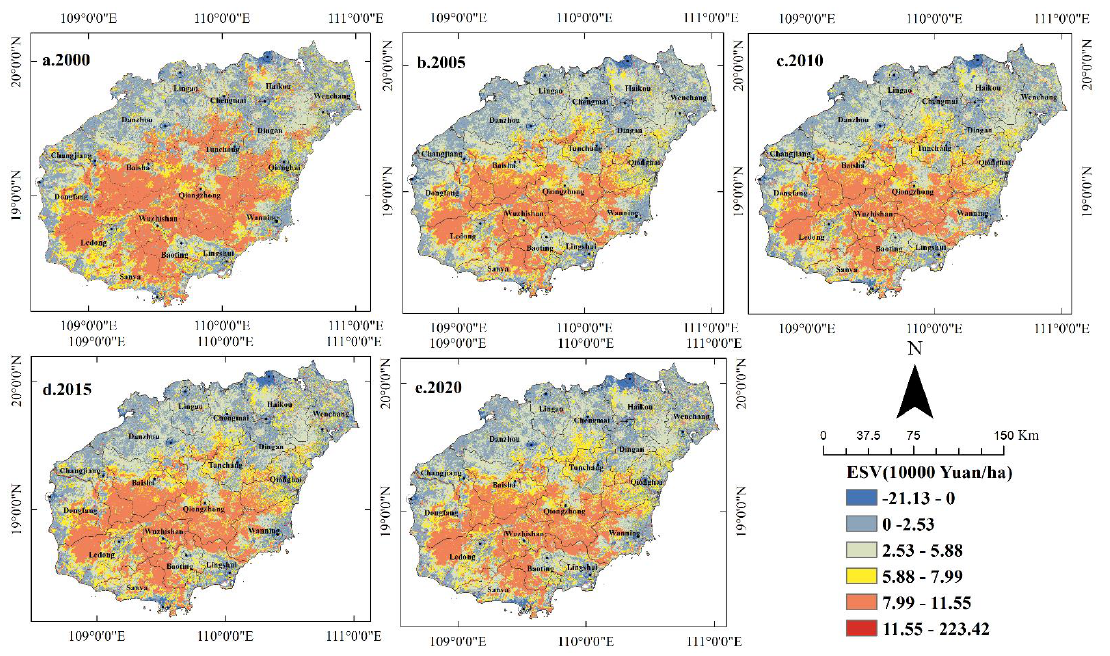
Figure 7. Distribution map of ESV in Hainan from 2000-2020. Note: (a) distribution map of ESV in Hainan in 2000; (b) distribution 500 Figure 8. Distribution map of ESV in Hainan from 2000 to 2020. ( a ) Distribution map of ESV in Hainan in 2000; ( b ) distribution map of ESV in Hainan in 2005; ( c ) distribution map of ESV in Hainan in 2010; map of ESV in Hainan in 2005; (c) distribution map of ESV in Hainan in 2010; (d) distribution map of ESV in Hainan in 2015; and (e) 501 distribution map of ESV in Hainan in 2020. 502